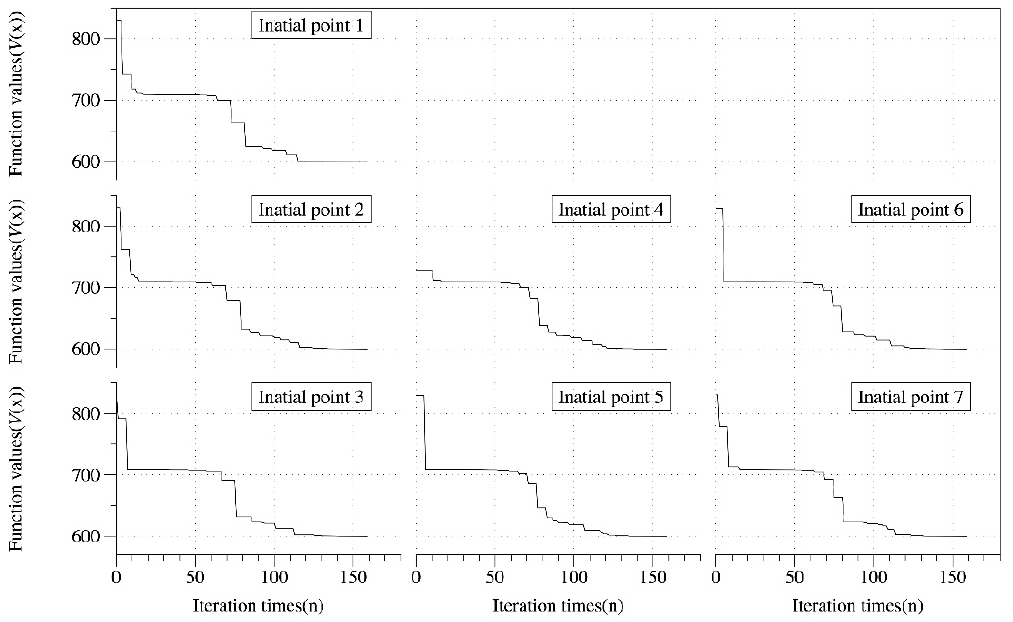
Figure 11. Initial points from matrix A with w scl = 0.5, w m = 0.5 and Thres =